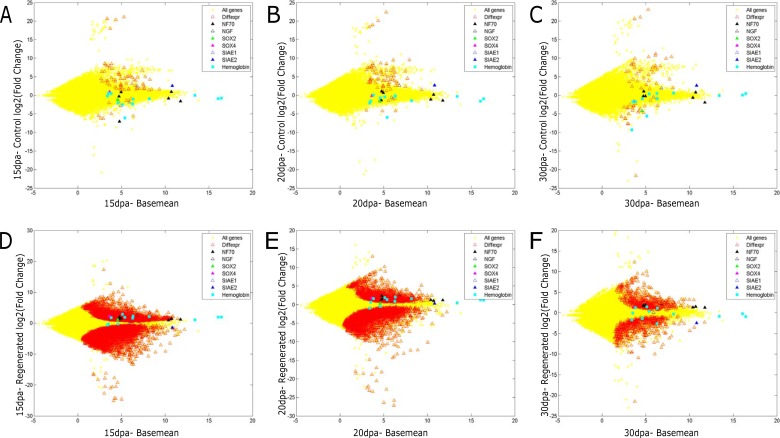
Scatter plot of fold change of genes in the (A-C) control region (Y-axis) and (D-F) regenerated region, compared to the basal expression level (basemean; X-axis) at 15, 20 and 30 days post amputation. Differentially expressed genes are marked in red. The genes analyzed in detail are highlighted. Divergent expression of two Sialidase isoforms is shown by blue triangles. Neurofilament, NF70 (black filled triangle) and Nerve Growth Factor (black open triangle) are unaffected in control tissue but induced in the regenerating tissue. Giant extra-cellular hemoglobin genes (cyan square), Sox4 (pink triangle), Sox2 (green triangle) re-gain expression in the regenerating tissue as regeneration proceeds.